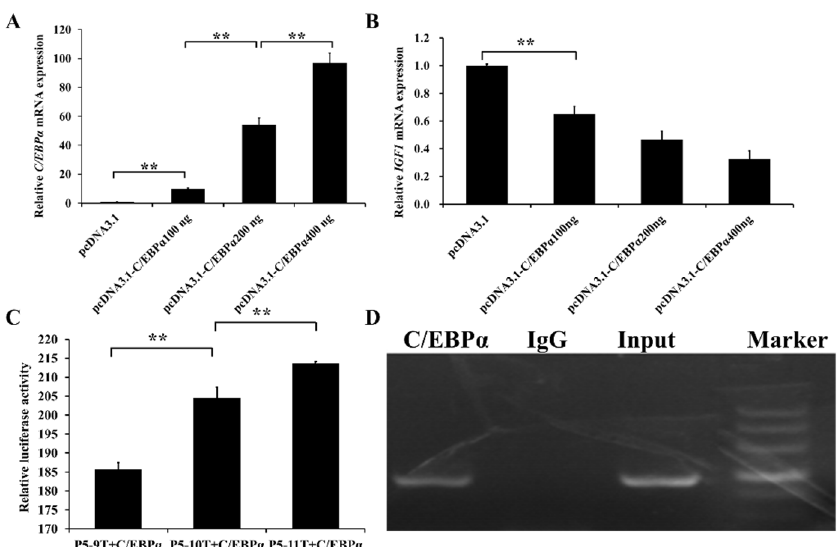
Figure 3. C/EBP α is critical for the expression of IGF1. ( A ): mRNA expression of C/EBP α at different concentration gradients of pcDNA3.1- C/EBP α . ( B ): mRNA expression of IGF1 at different concentration gradients of pcDNA3.1- C/EBP α . ( C ): Luciferase assay of PFF cells co-transfected with different tract 2 genotypes and C/EBP α . ( D ): Binding of C/EBP α sites to IGF1 in vitro detected using ChIP. The input lanes correspond to PCR products derived from chromatin prior to immunoprecipitation. The IgG lanes correspond to PCR products containing chromatin immunoprecipitated with antibodies against control IgG. The C/EBP α lanes correspond to PCR products containing chromatin immunoprecipitated with antibodies against C/EBP α . Marker indicates DNA 2000 marker. ** was annotated as p < 0.01.